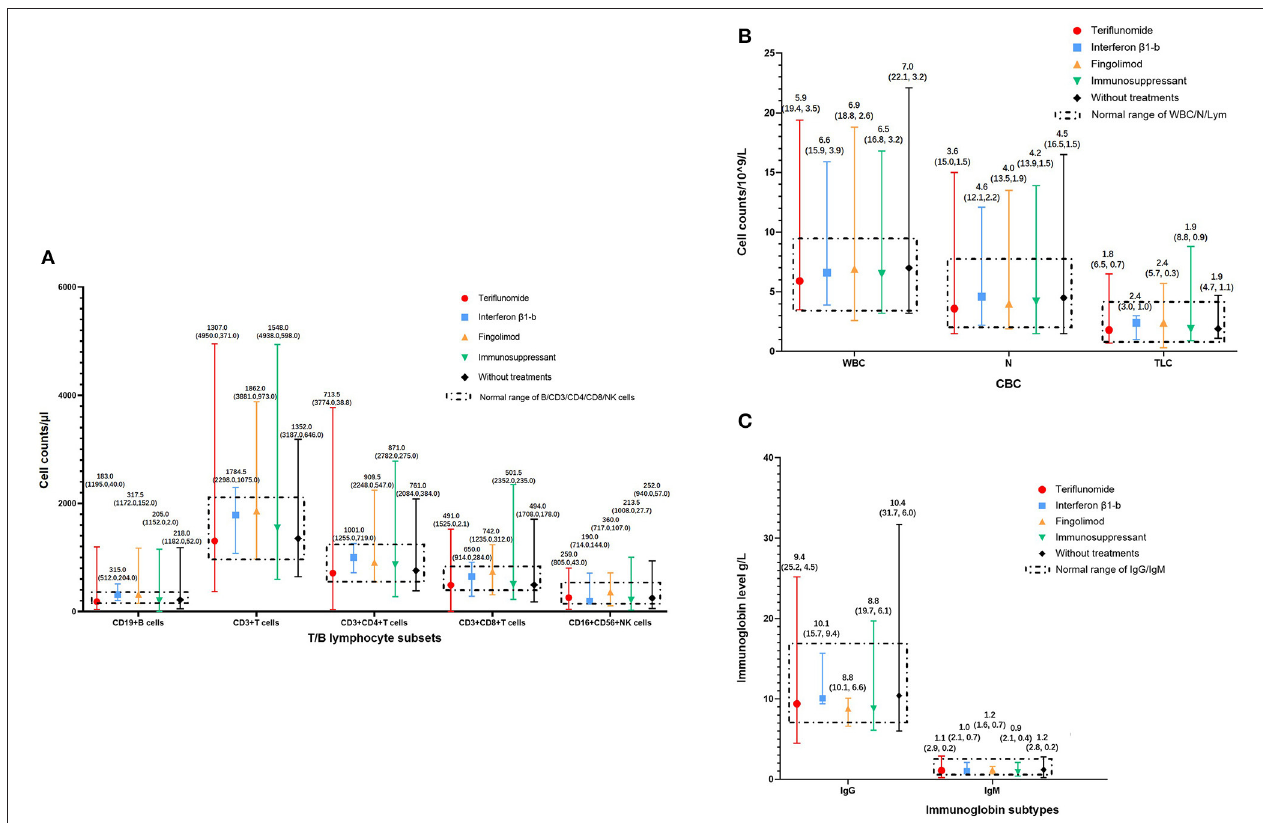
FIGURE 3 | Immune status of MS patients on immunotherapies in COVID-19 pandemic. (A) T/B lymphocyte subsets of MS patients on immunotherapies in COVID-19 pandemic, categorized according to DMTs. (B) White blood cells, neutrophil granulocytes, and total lymphocyte counts of MS patients in COVID-19 pandemic, categorized according to DMTs. (C) Immunoglobin levels of MS patients in COVID-19 pandemic, categorized according to DMTs. CBC, Complete Blood Count; COVID-19, coronavirus disease 2019; DMTs, Disease-Modifying Therapies; Ig, Immunoglobin; MS, Multiple Sclerosis; N, neutrophil granulocytes; NK cells, Natural Killer cells; TLC, Total Lymphocyte Counts; WBC, White Blood